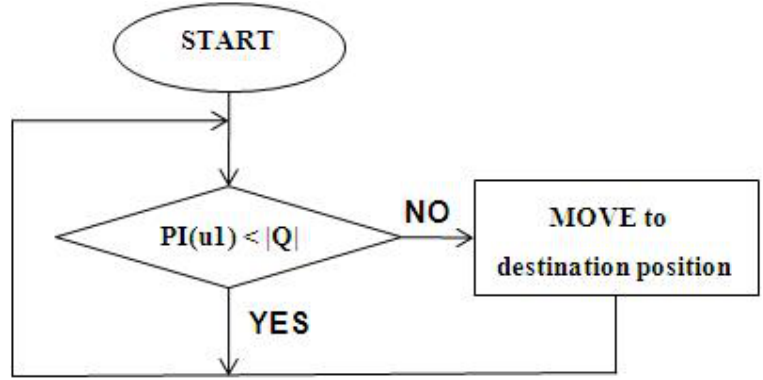
Figure 7. Flow diagram of reference tracking